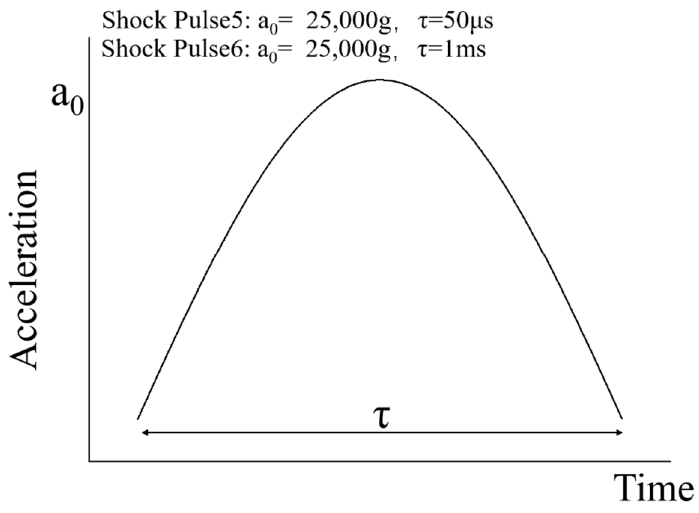
Figure 10. The X-axis shock pulses of Shock Pulses 5 and 6 applied in the simulation.